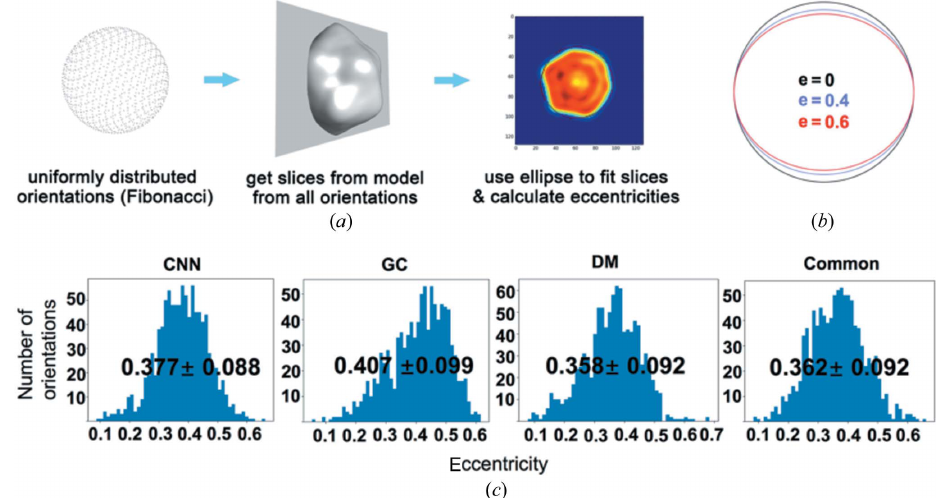
Figure 7 The shape analysis of the reconstructed maps. ( a ) An illustration of the cross-section slicing procedure: a Fibonacci sampling algorithm was used to select the direction of the planes that pass through the model centre. ( b ) Ellipses with three eccentricity values to guide the understanding of the deviation from a perfect circle. ( c ) The distribution of eccentricity values of map cross-sections for four reconstructed maps.